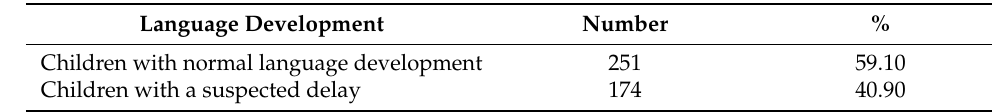
Table 1. The children’s language development status ( n = 425).